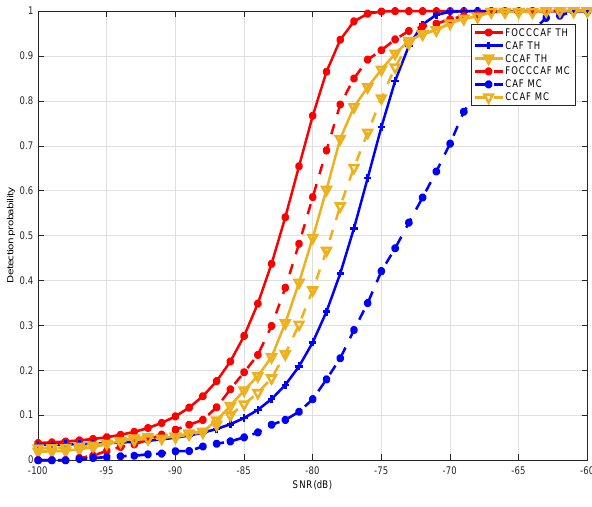
Figure 8. Detection performance comparison with different